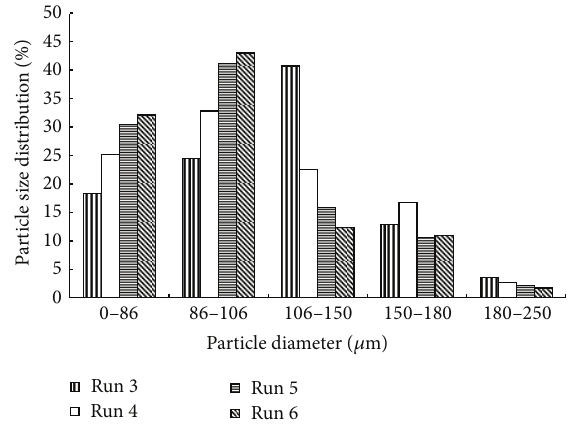
Figure 3: Product size distribution of pulverized biomass as a function of blades gap of advanced crusher.